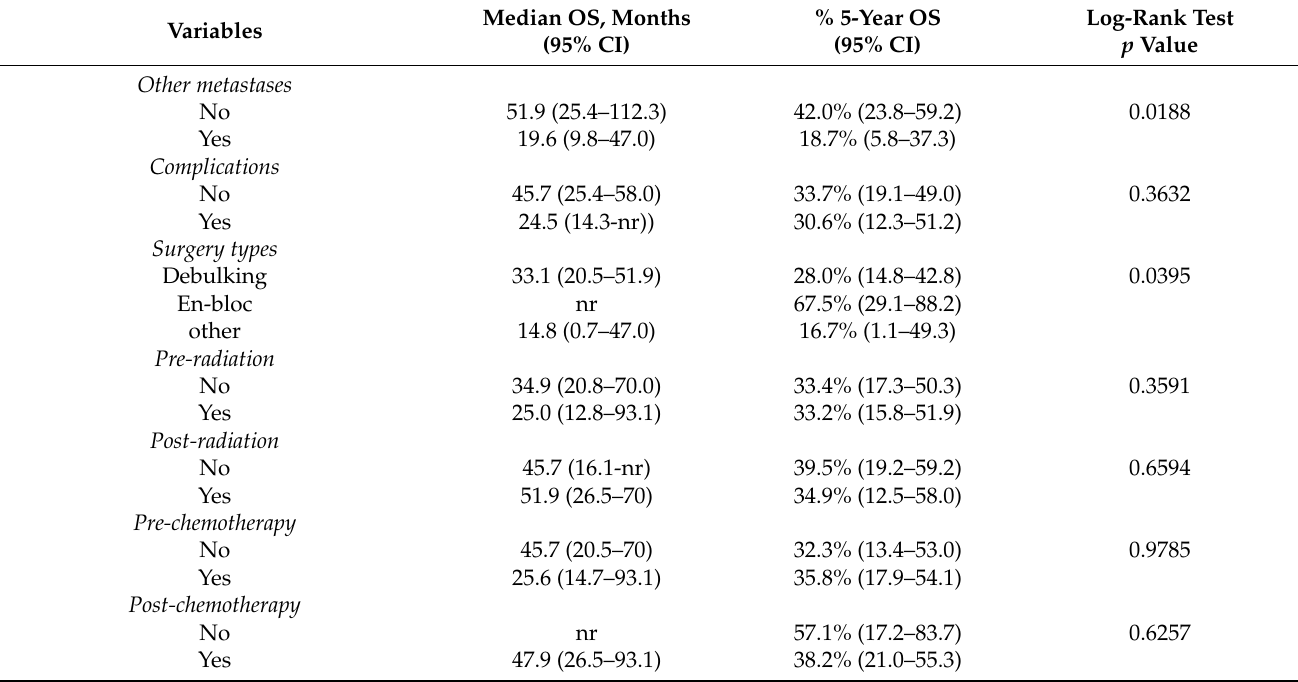
Table 6. Univariate analysis of the prognostic factors affecting 3-year progression-free survival (PFS).